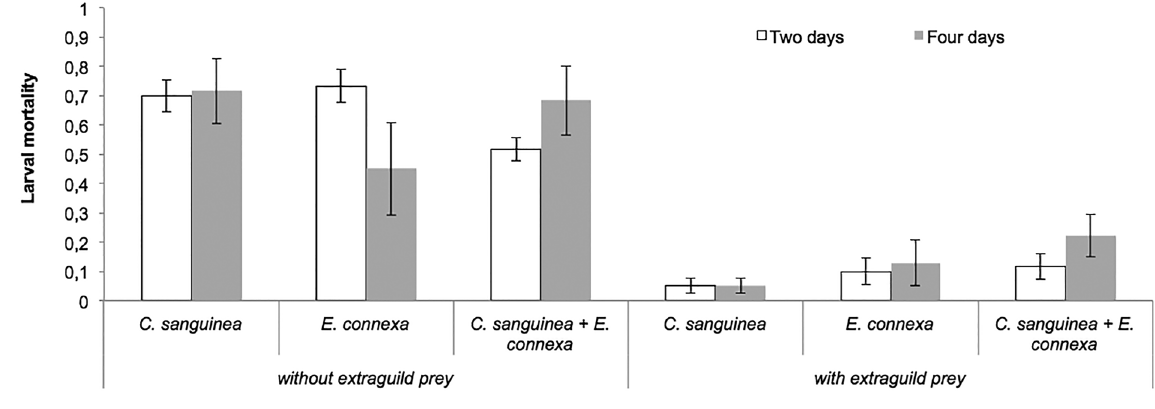
Figure 5. Mean larval mortality of Cycloneda sanguinea (six larvae), Eriopis connexa (six larvae), and both species together (three C. sanguinea + three E. connexa larvae) at two (white bars) and four (gray bars) days after the start of the experiment, either with or without additional prey ( Myzus persicae aphids). In the figure, larval mortality, expressed as a fraction of the total larvae present, is plotted on the vertical axis for each of the experimental groups indicated on the horizontal axis, with a single species denoting cannibalism and both species intraguild predation. The initial larval stage was L1. The brackets indicate the standard